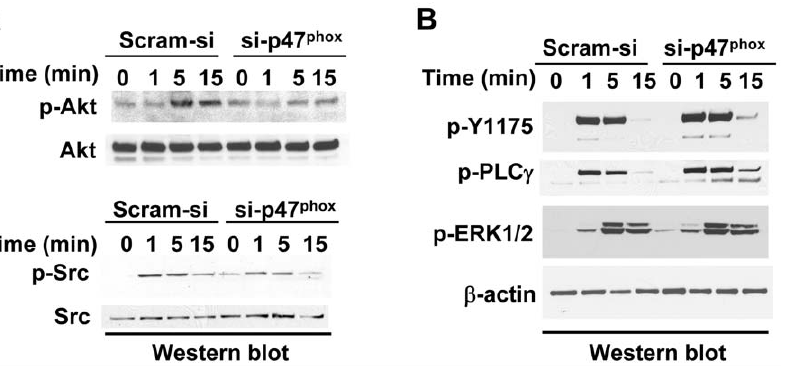
Figure1. VEGF-induced activation of c-Src, Akt, butnotVEGFR-2,PLC c -1 andERK1/2requiresNADPH oxidase-derivedROS. (A) Protein extracts from HCAEC transfected with control siRNA (Scram-si) or si-p47 phox were subject to Western blots as described in Materials and methods. Serum-starved HCAEC were treated with VEGF (50 ng/ml) for the times indicated. Membranes were sequentially blotted, stripped and re-probed with the phospho-specific antibodies as shown. Blots shown are representative of three independent experiments. (B) Same as in (A) except, the membranes were probed for phosphorylation of Y1175 VEGFR-2, Y783 PLC c -1 and p42/44 ERK1/2. Anti- b -actin antibody was used as loading control.